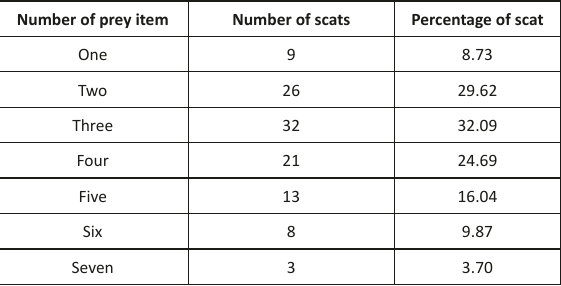
Table 1. Percentage of scats containing different number of prey items. Number of prey item